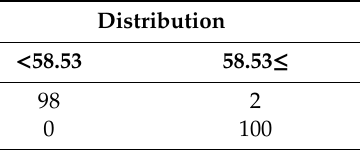
Figure 10. The distribution of the mutation degree of different anomalies. Table 4. The distribution of the mutation degree of different anomalies.